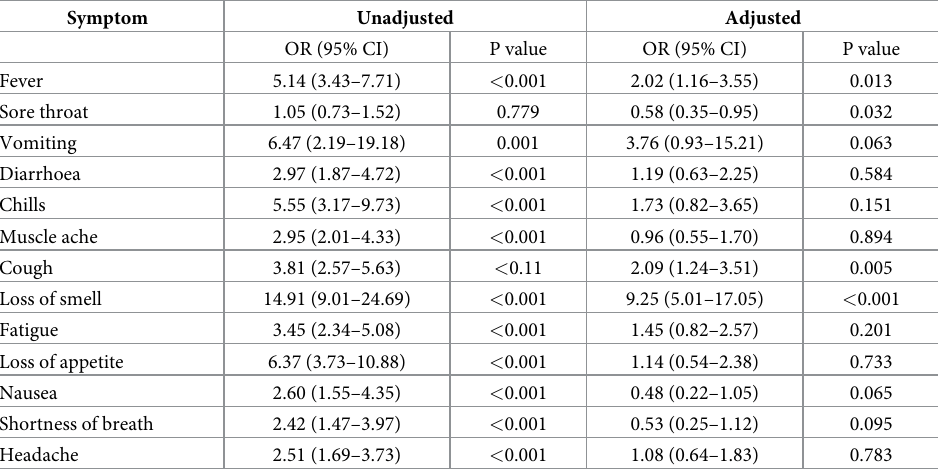
Table 3. Risk factors (symptoms) associated with positive SARS-CoV-2